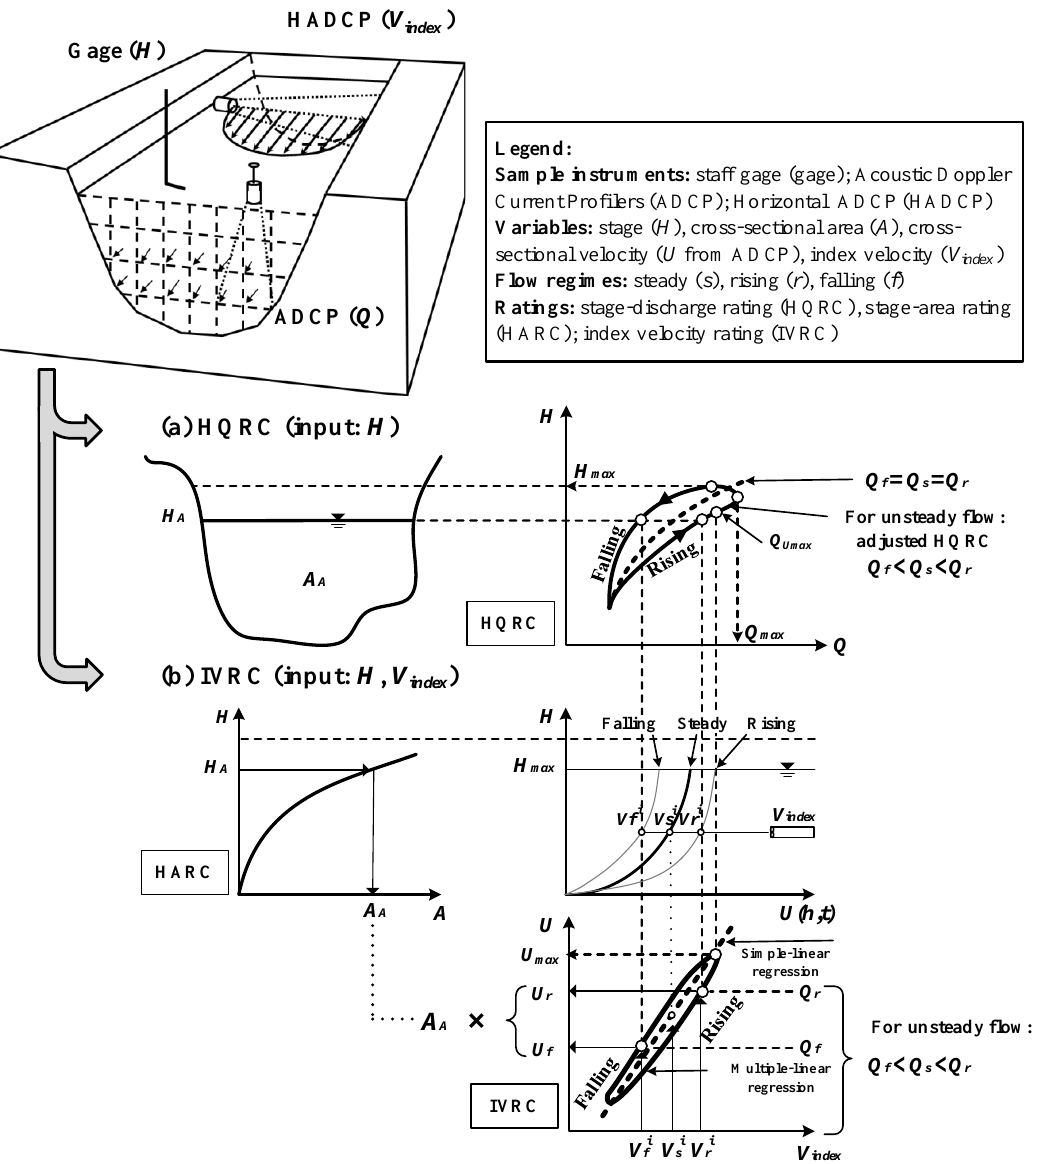
Figure 1. Outcomes of the conventional monitoring methods when measurements were conducted during unsteady flows (adapted from [8]): ( a ) stage-discharge method (HQRC) and ( b ) index-velocity method (IVRC).